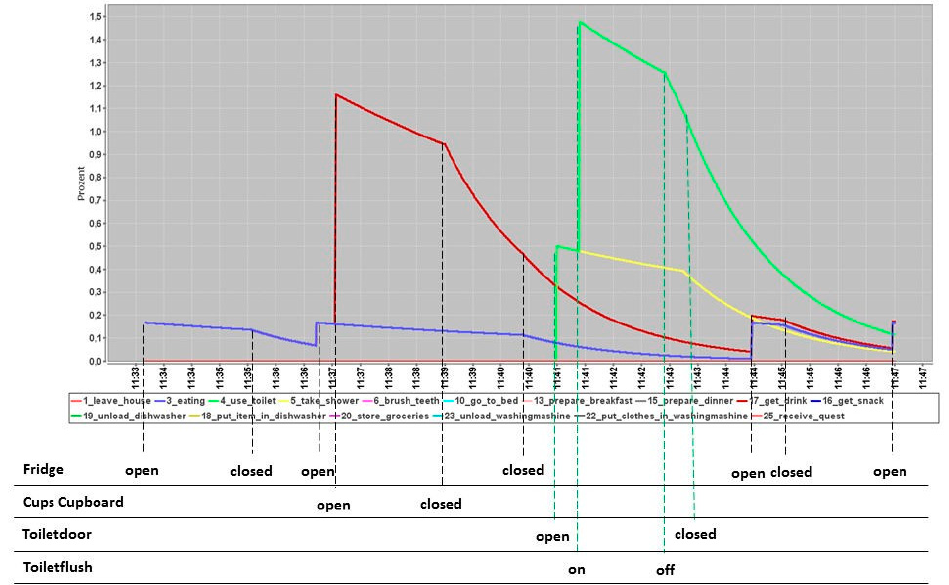
Figure 3. The human forgetting curve impulse (hfci) with the equal distribution of sensor-ADL-assignment (sensor probability distribution function (spdf)). Each colored function curve represents the impulse curve hfci for one ADL. The table underneath the curve diagram shows the corresponding sensor events.